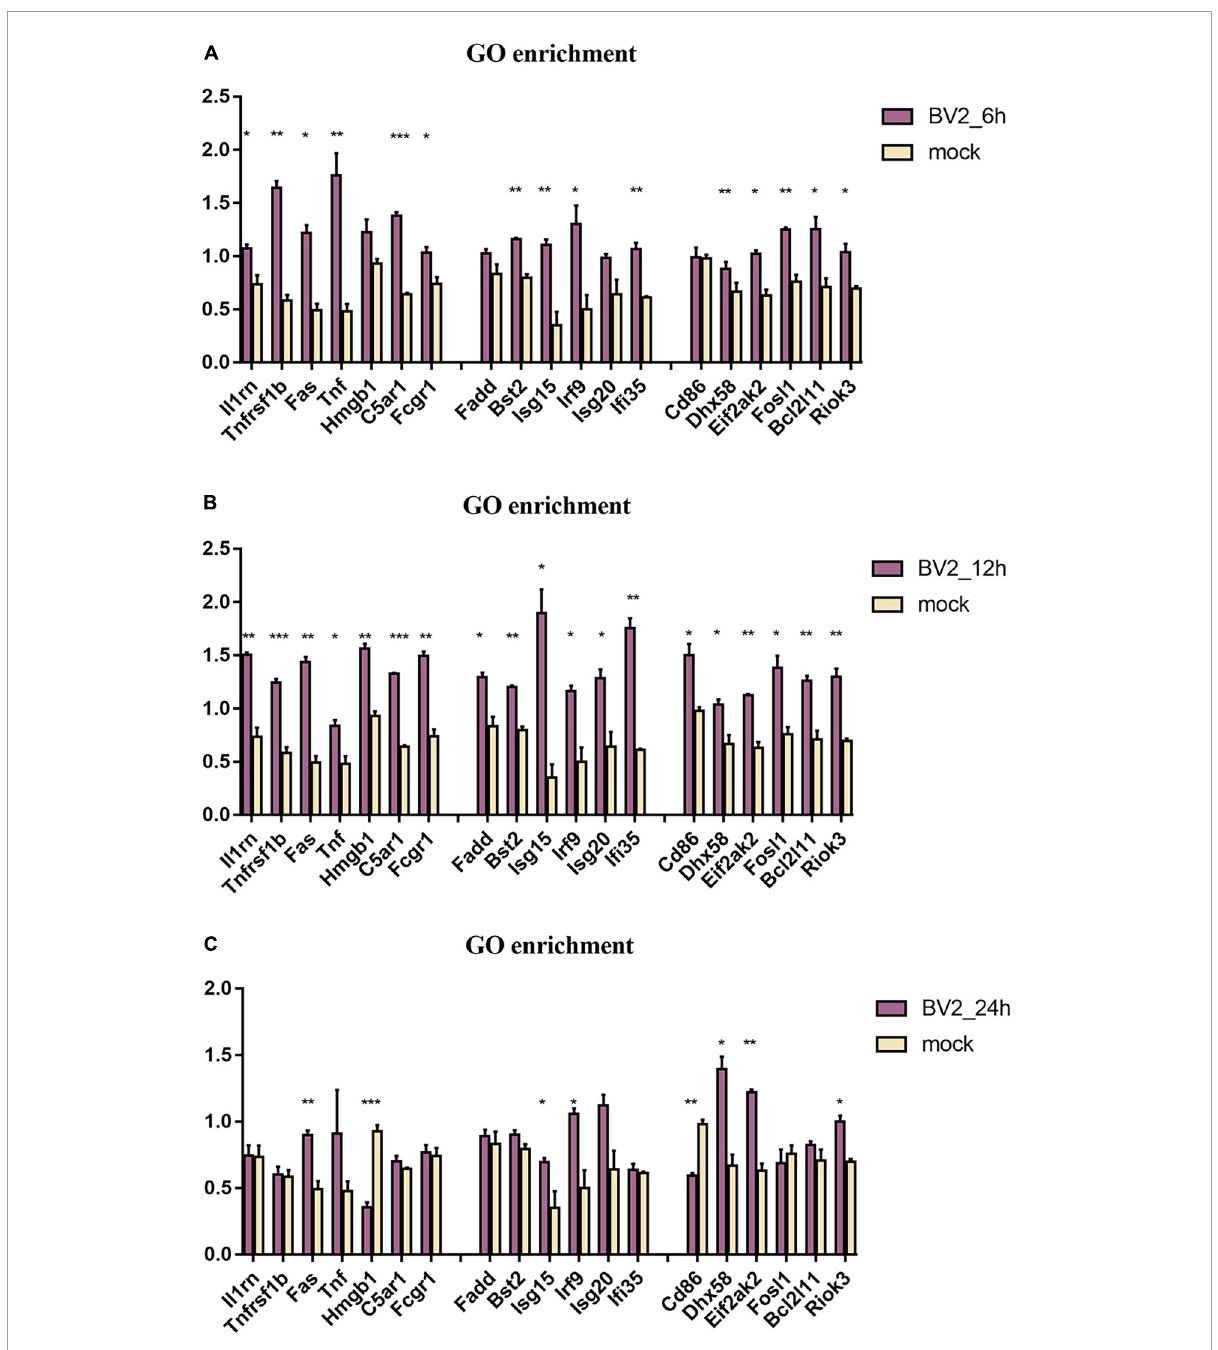
FIGURE3 Regulation of proteins associated with immune in BV2 cells after infection with JEV at (A) 6 hpi, (B) 12 hpi, and (C) 24 hpi. Significant changes were found in the expression of inflammation-related proteins Fas, TNF, Fosl1, Hmgb1, Riok3, as well as apoptosis-related proteins Fadd, Fas, TNF, and interferon-related proteins Irf9, Isg20, Ifi35. These suggested that JEV infection induces broad immune responses, with the inflammatory response being one of the key immune responses. All the samples were tested through three parallel groups. * P < 0.05, ** P < 0.01, and *** P <